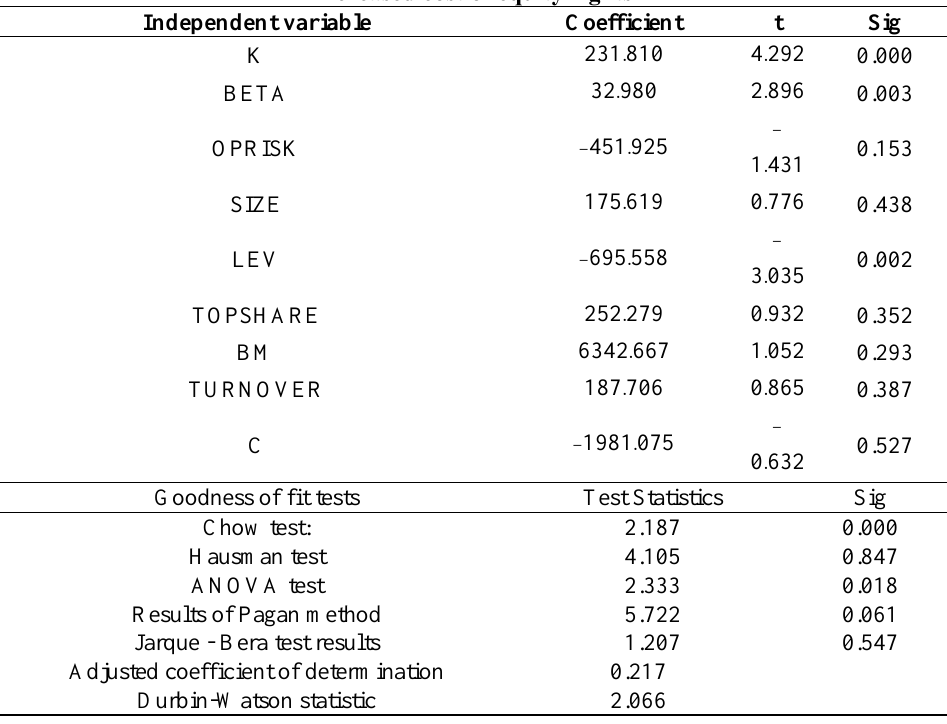
Table 3. The divergence role of the controlling shareholder right of the cash flow in increased cost of equity rights Independent